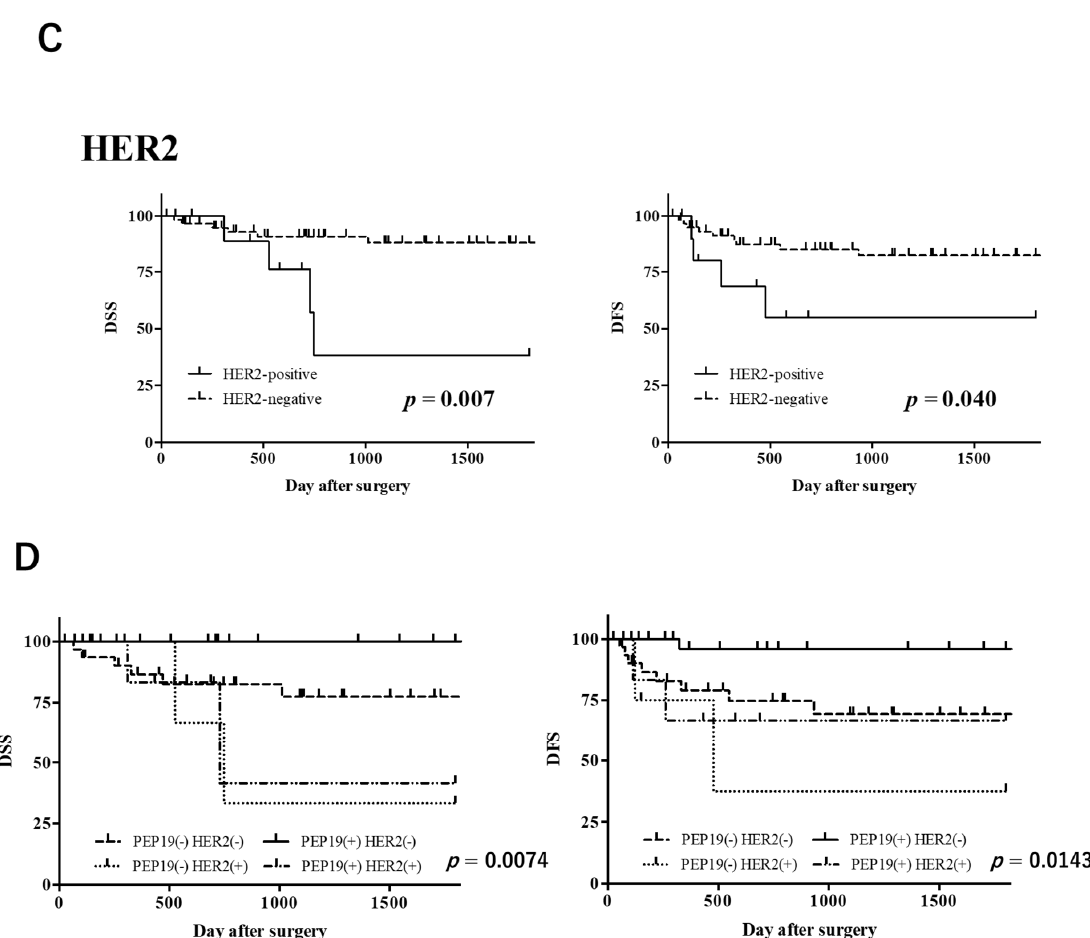
Figure 2. Kaplan–Meier curves for the DFS and DSS of MEC patients within the first five years after surgery, according to PCP4/PEP19 ( A ); EGFR ( B ); and HER2 ( C ) expression. Since PCP4/PEP19 and HER2 were significantly related to DSS and DFS, the Kaplan–Meier curve is shown for combined expression ( D ). DFS, disease-free survival; DSS, disease-specific survival; MEC, mucoepidermoid carcinoma; Purkinje cell protein 4 (PCP4)/peptide (PEP) 19, brain-specific polypeptide; EGFR, epidermal growth factor receptor; HER2, human epidermal growth factor receptor type 2; PEP19(+)HER2(+), PCP4/PEP19-positive and HER2-positive; PEP19(+)HER2( − ), PCP4/PEP19-positive and HER2-negative; PEP19( − )HER2(+), PCP4/PEP19-negative and HER2- positive; PEP19( − )HER2( − ), PCP4/PEP19-negative and